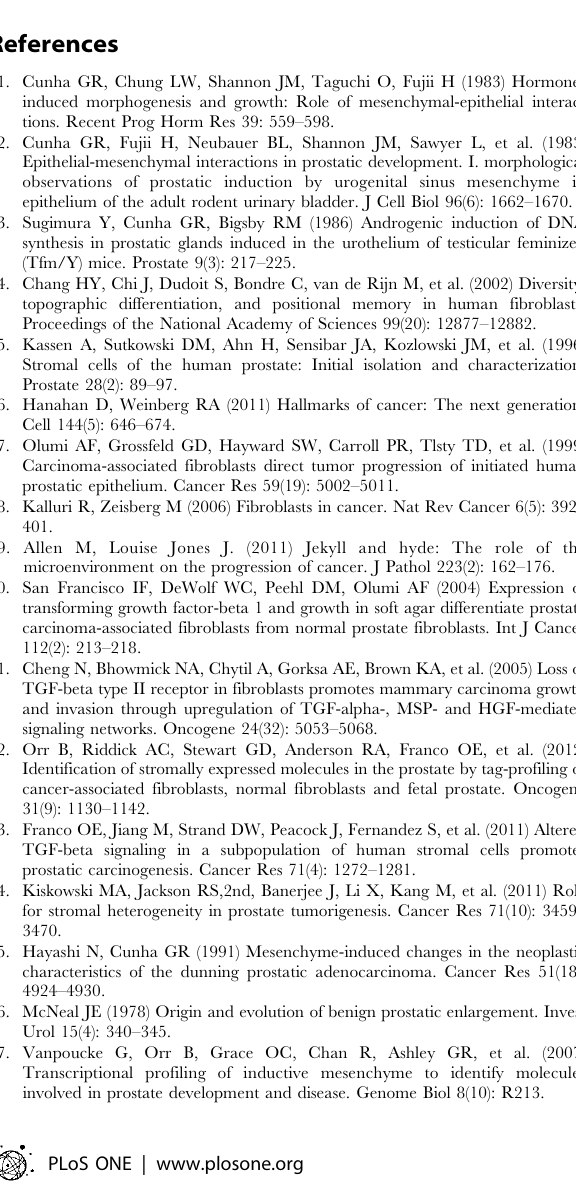
Table S1 Pathological details of pre-treatment-naı¨ve PCa patients undergoing transurethral resection of the prostate. Table S2 Pathological details of PCa patients in the tissue micro array A222(II). Table S3 Pathological details of PCa patients in the tissue micro array